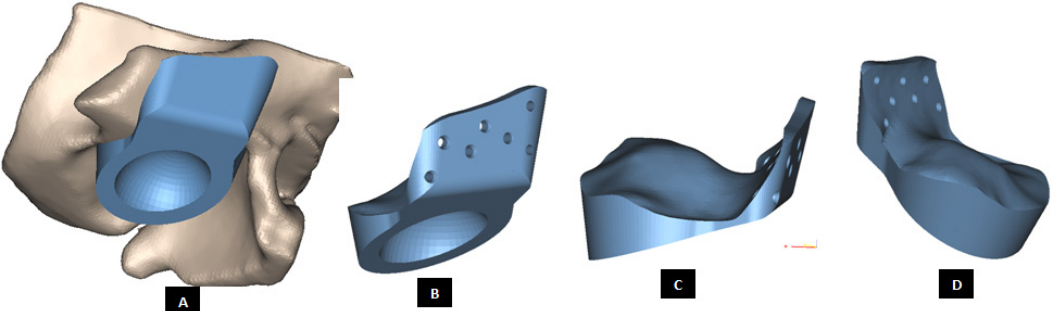
Figure 16. Patient-fitted fossa implant with circular inferior surface which also has a circular grove for articulation with condylar head. Visuals in ( A – D ) demonstrate the customized size and shape of the implant.